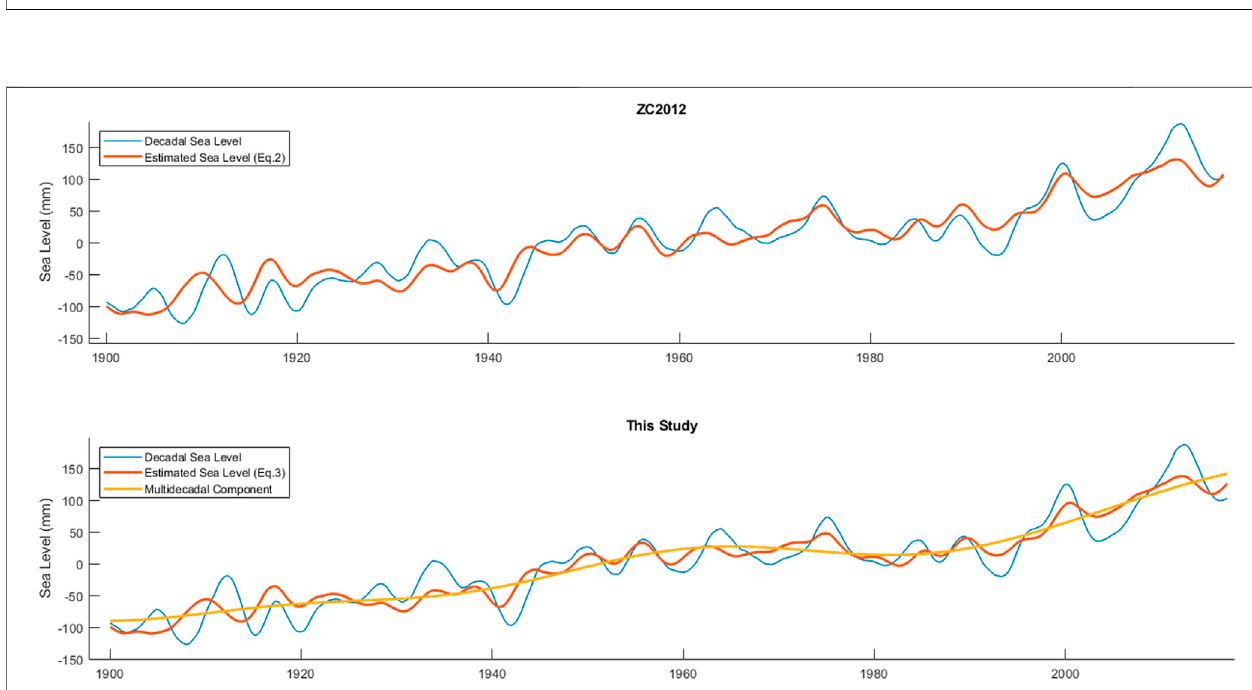
FIGURE 3 | Fitting of PDO (top panel) and TPI (bottom panel) to the low-passed SLA in Fremantle by Eq. 2 and Eq. 3 , respectively. TPI explains the internal variability in Fremantle slightly better than PDO on decadal and multidecadal time scales when coef fi cient of determinations of Eq. 2 and Eq. 3 are compared.